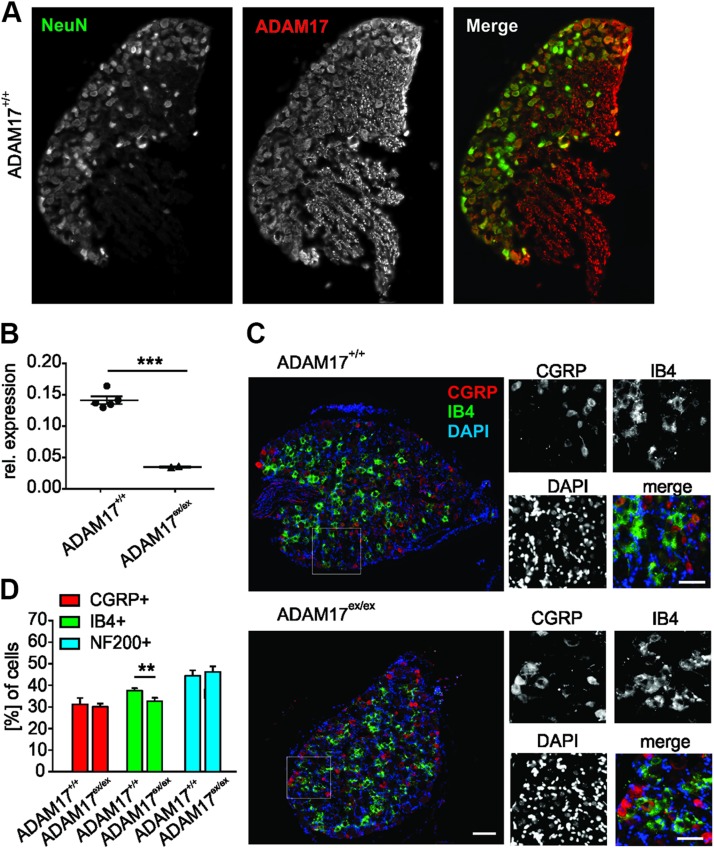
ADAM17 localizes in neurons in DRG, and its down-regulation affects the IB4-positive nociceptive subpopulation. A) Expression of ADAM17 in neurons in DRG cryo-sections. Neurons were identified by neuronal nuclei protein (NeuN) staining. Scale bar, 100 µm. B) ADAM17 mRNA was detected in DRG from ADAM17+/+ mice and barely in hypomorphic ADAM17ex/ex mice (n = 5; unpaired Student’s t test with Welch’s correction, P < 0.001). C) Representative image of DRG stained for the peptidergic [IB4-positive (IB4+)] and nonpeptidergic [CGRP-positive (CGRP+)] neuronal populations showing similar morphology of ADAM17+/+ and ADAM17ex/ex DRG. D) The percentage of the nociceptive IB4-positive neurons was found to be significantly decreased in ADAM17ex/ex DRG compared with ADAM17+/+ (ADAM17+/+
n = 3485, ADAM17ex/ex
n = 2602; χ2 test, P = 0.0046). The number of CGRP+ and NF200-positive (NF200+) neurons was similar in the 2 genotypes (CGRP; ADAM17+/+
n = 2050, ADAM17ex/ex
n = 3216; χ2 test, P = 0.5161; NF200; ADAM17+/+
n = 2050, ADAM17ex/ex
n = 1756; χ2 test, P = 0.0775). Scale bars, 200 µm. Results are shown as means ± sem. **P < 0.01, ***P < 0.001.